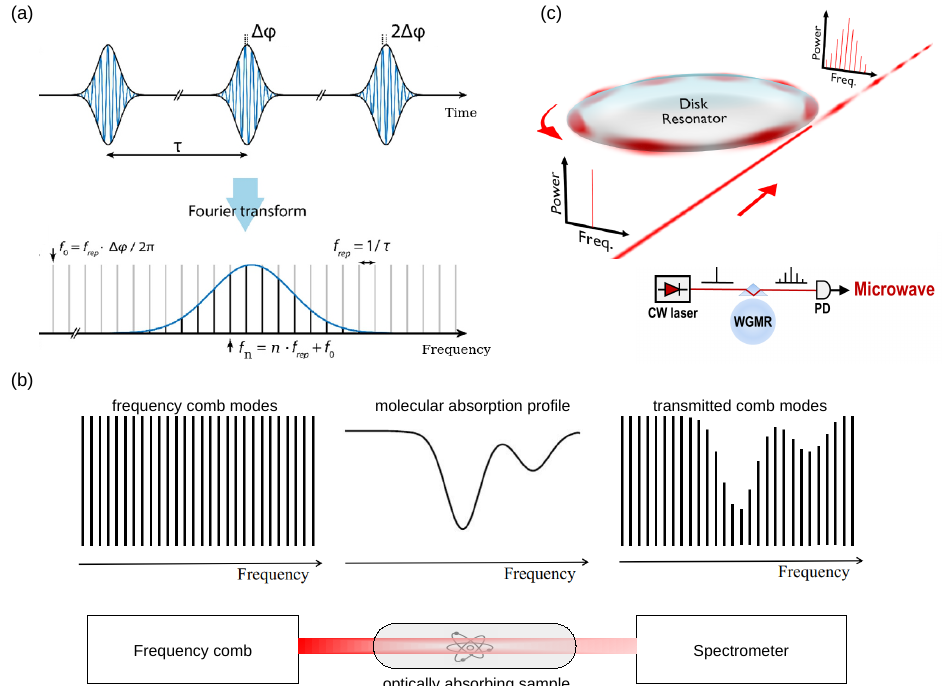
Figure 2. ( a ) Schematic of the OFC generation using a mode-locked laser. The top panel shows a train of optical pulses with a period 1/ f rep . The bottom panel depicts the spectrum of narrow frequency peaks corresponding to the train of pulses in the time domain. The phase shift ∆ φ of the carrier wave with respect to the pulse envelope induces a translation f 0 = f rep ∆ φ /2 π of spectral peaks from their harmonic frequencies nf rep . Reproduced from [2] with permission from Elsevier. ( b ) Sketch of an OFC-based spectroscopy technique. The OFC as a broadband light source interrogates an absorbing sample and a spectrometer analyses the transmission spectrum. ( c ) Artist’s rendition of a Kerr effect-based OFC generation in a micro-photonic disc resonator. A continuous-wave (CW) input pump wave creates a pattern of optical whispering-gallery modes (WGMs) inside the disc resonator, thereby inducing a periodic light intensity modulation and thus producing an output signal with an OFC-like spectrum. The bottom panel shows the sketch of a simplified experimental setup for the generation of a Kerr OFC and its further processing using a photodetector (PD).